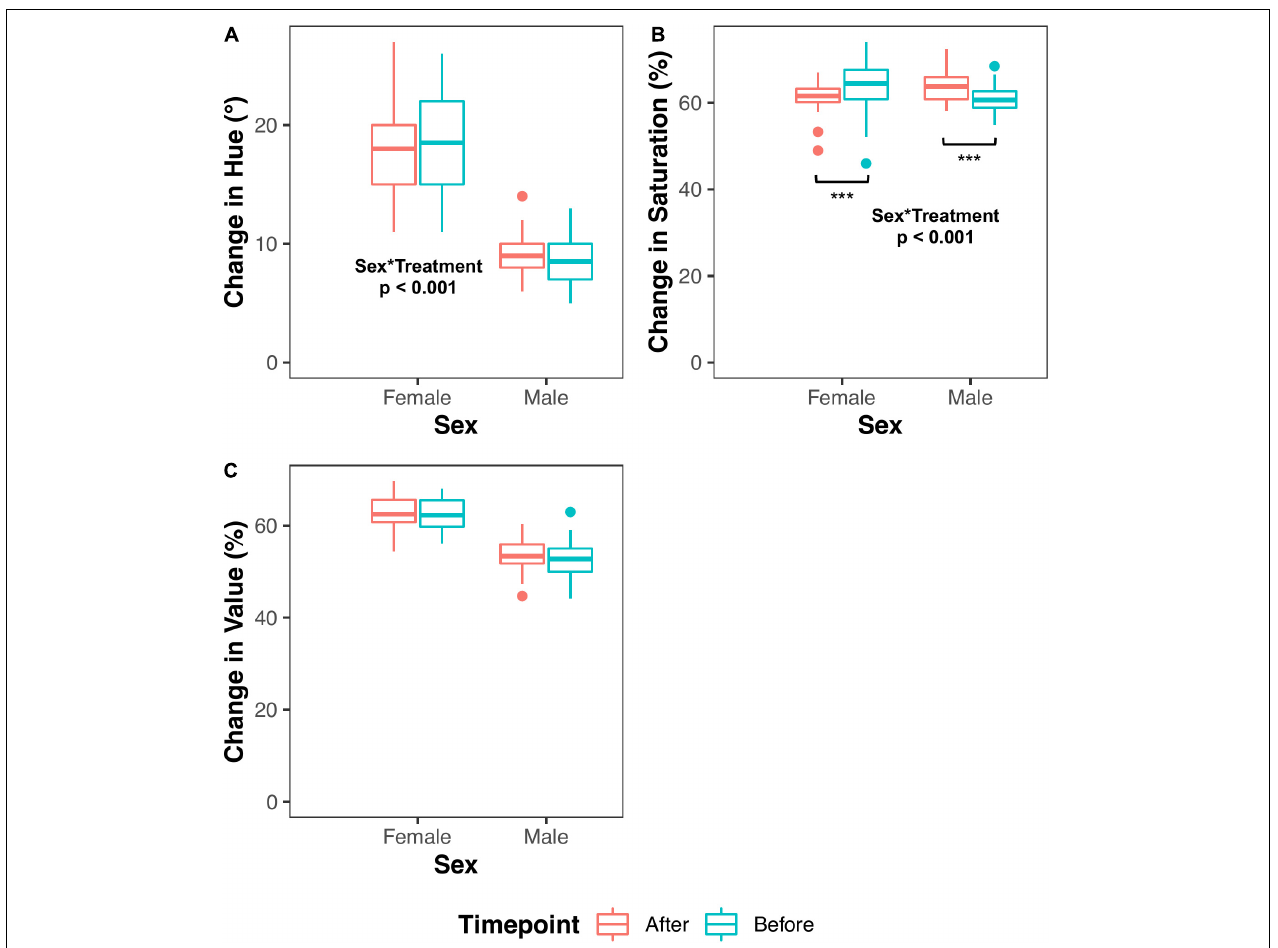
FIGURE 5 | Beak hue and saturation are impacted by repeated capture and restraint. The change in the beak color parameter (hue, saturation, or value) is presented on the y-axis, and sex is shown on the x-axis. Data indicated in red boxplots are indicative of “Before” the handling bag test, whereas blue boxplots are indicative of “After” the handling bag test. Significant sex*timepoint interactions are mentioned where applicable. (A) Female beak hue significantly decreases following the initial handling bag test. (B) Both male and female beak saturation are inversely affected following the initial handling bag test. (C) There are no effects of the handling bag test on beak value. Three asterisks (***) indicate P ≤ 0.001.